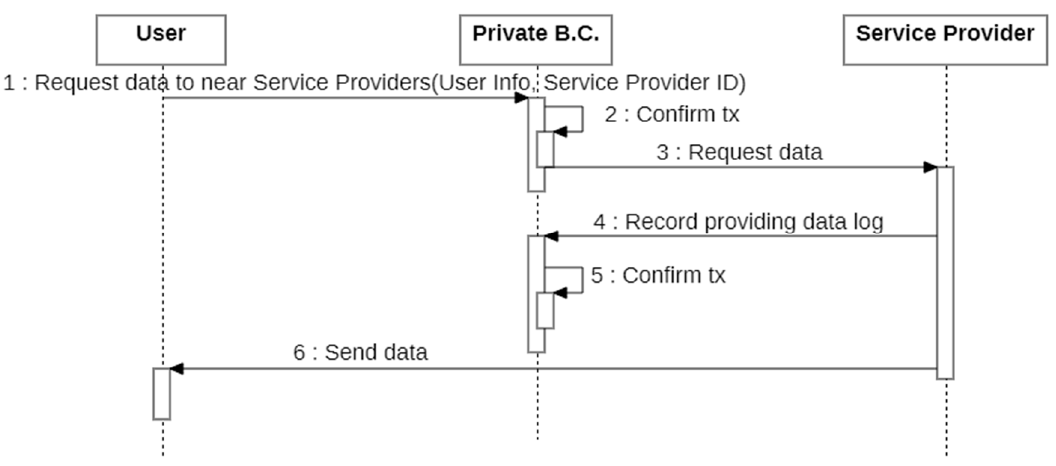
Figure 8. Sequence diagram for the data request of a user.